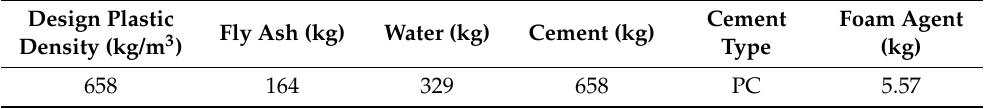
Table 2. Mixing design for foam concrete with different densities (per m 3